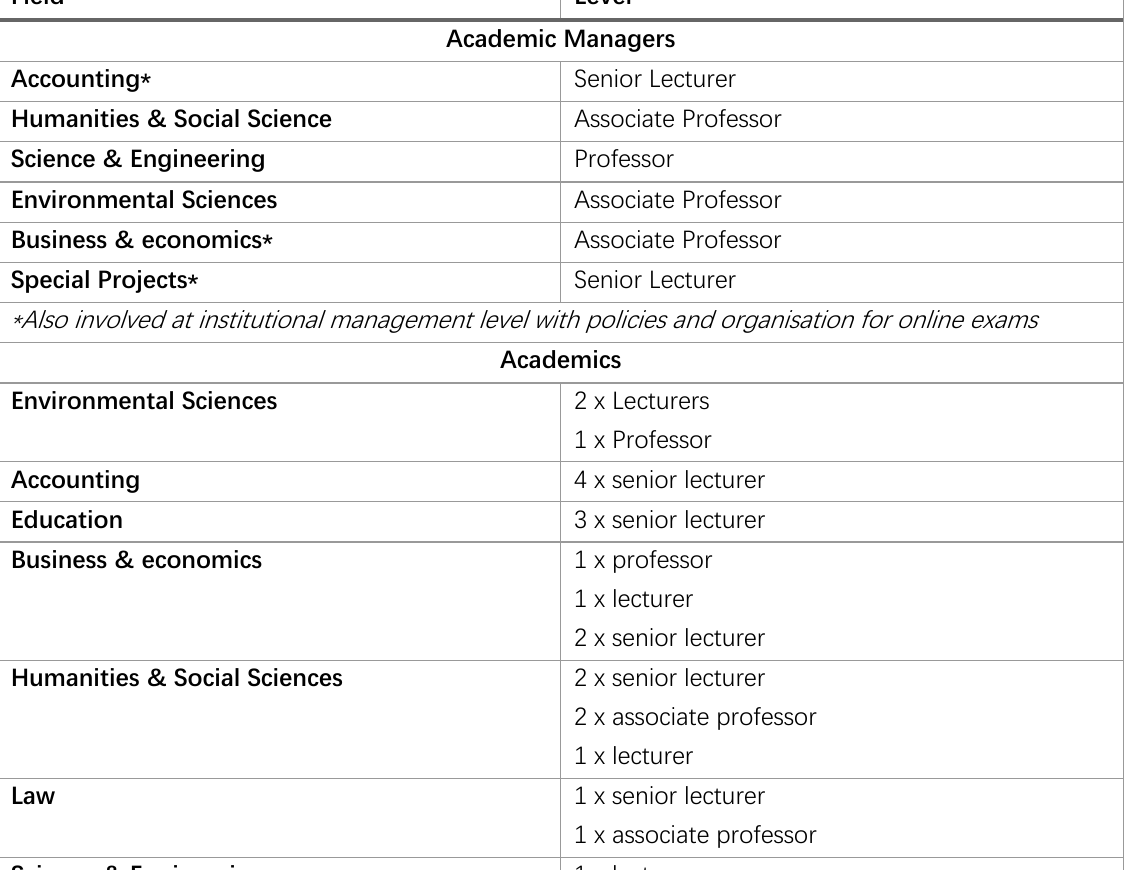
Table 1 : Table with participants